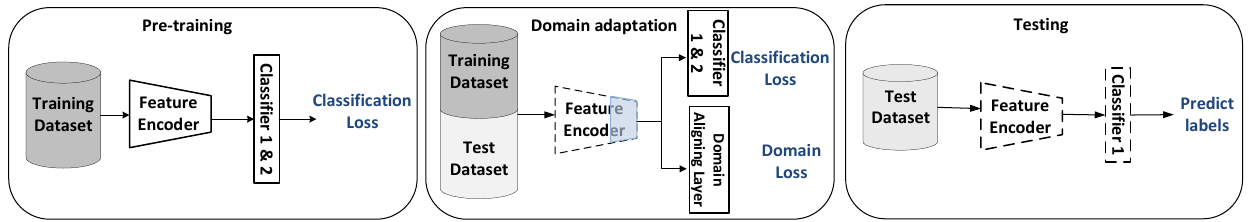
Figure 1. An overview of our proposed domain-based, adaptive, multi-scale network for sleep stage classification. First, the model is pre-trained on the training set. Classifier 1 makes predictions based on the current sequence, while Classifier 2 makes predictions based on the previous 30 s sequence. Next, the domain-aligning layer is utilized to adjust the high-level part of the feature encoder such that the domain gap between the training set and test set can be reduced during the process of classification. Finally, the test dataset is mapped with the adjusted feature encoder to the shared feature space and classified by Classifier 1. Dashed lines indicate fixed network parameters. The blue area indicates the part that needs to be